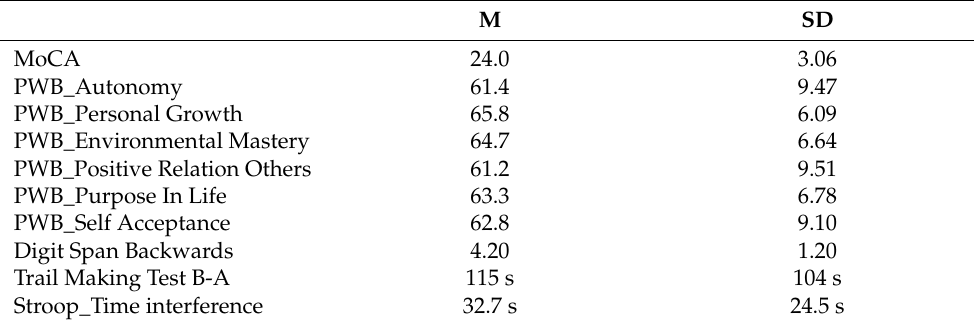
Table 1. Means (M) and Standard Deviations (SD) of the considered variables.